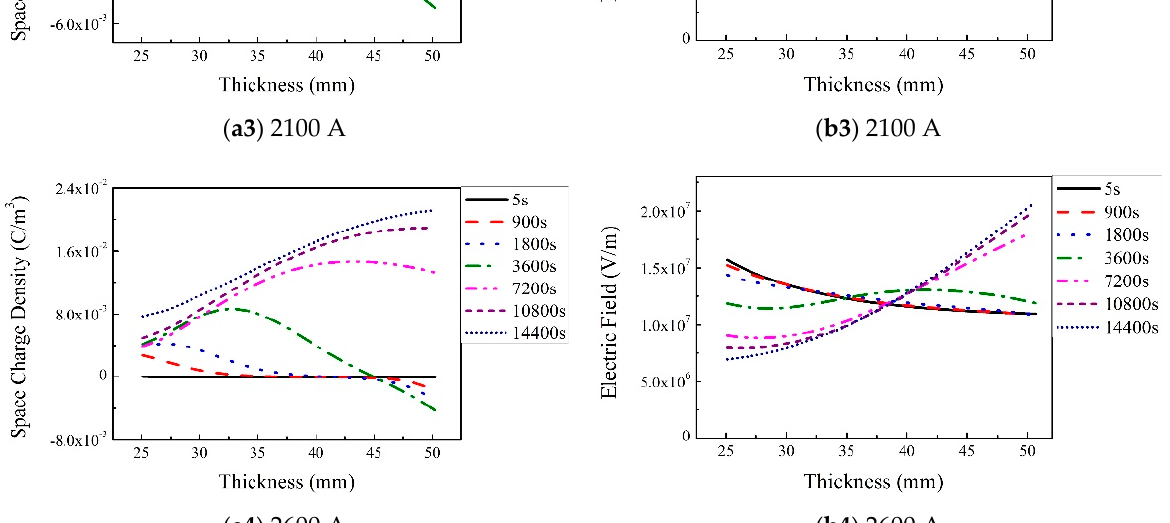
Figure 10. Simulation results of space charge distribution( a1 – a4 ) and electric field distribution( b1 – b4 ) in HVDC insulation when the trap density is 80 × 10 19 m − 3 , trap depth is 0.94 eV with load current varying from 0 A to 2600 A under 320 kV.